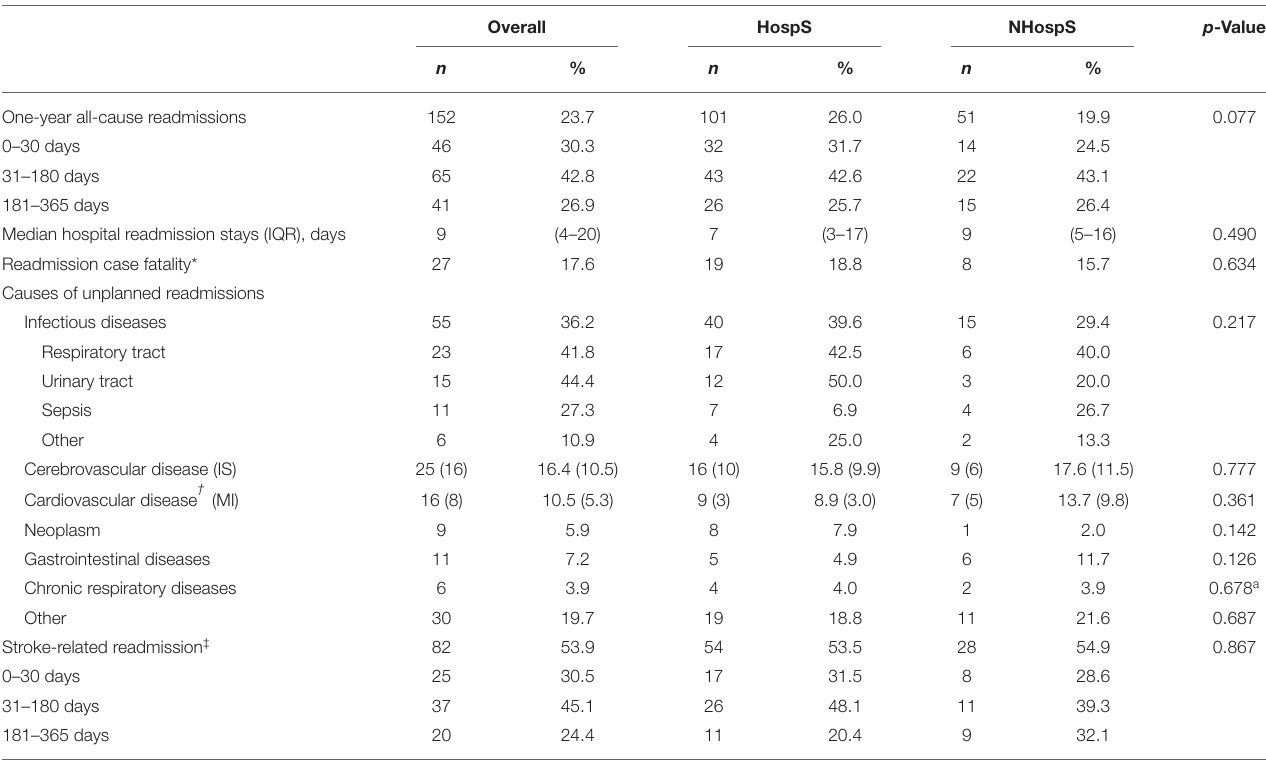
TABLE 3 | Characteristics and causes of patients’ all-cause readmissions within 1 year ( n =